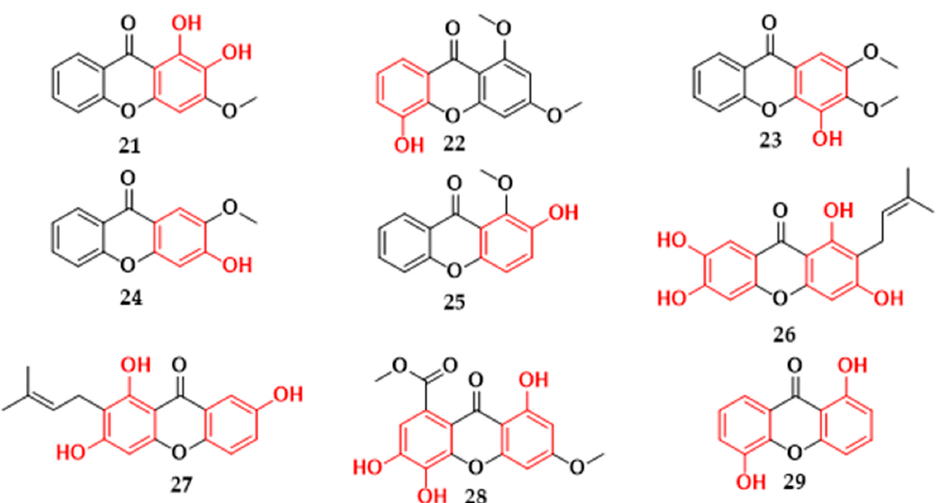
Figure 5. Xanthones with antibacterial activity isolated from plants in Brazil. 3,4-dihydroxy-2-meth- oxyxanthone ( 21 ), 5-hydroxy-1,3-dimethoxyxanthone ( 22 ), 4-hydroxy-2,3-dimethoxyxanthone ( 23 ), 3-hydroxy-2-methoxyxanthone ( 24 ), 2-hydroxy-1-methoxyxanthone ( 25 ), Assiguxanthone B ( 26 ), 1,3,7 ′ trihydroxy-2-(3-methylbut-2-enyl)-xanthone ( 27 ), 8-carboxymethyl-1,3,5,6-tetrahydroxyxan- thone ( 28 ), 1,5-dihydroxyxantona ( 29 ) . The prenylated xanthone 1,3,7 ′ trihydroxy-2-(3-methylbut-2-enyl)-xanthone ( 27 ) (Fig- ure 5) isolated from Kielmeyera coriacea species proved to be a potent inhibitor against the Gram-positive bacteria S. aureus (ATCC 25923) and B. subtilis (ATCC 6623), exhibiting a